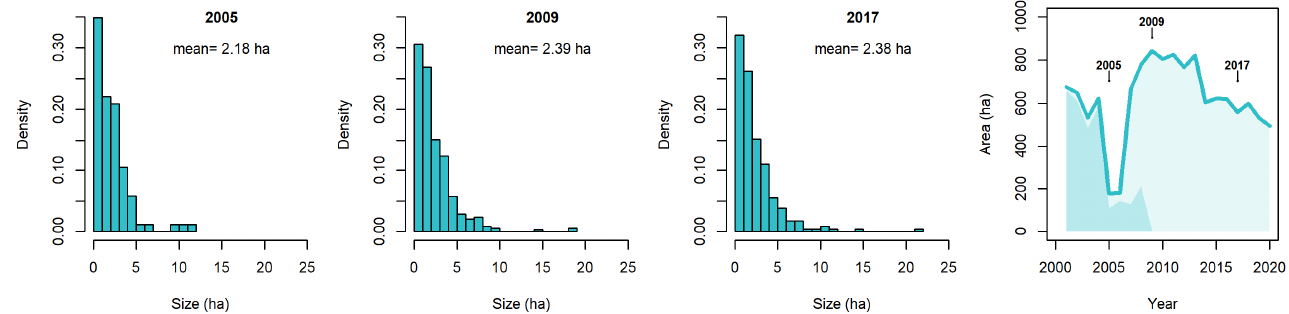
Figure 1. Evolution of area cultivated with reed canary grass land for the period 2001–2020 and distribution of the plantations according to their size. Shaded area refers to non-contractual plantations (largely before 2009).